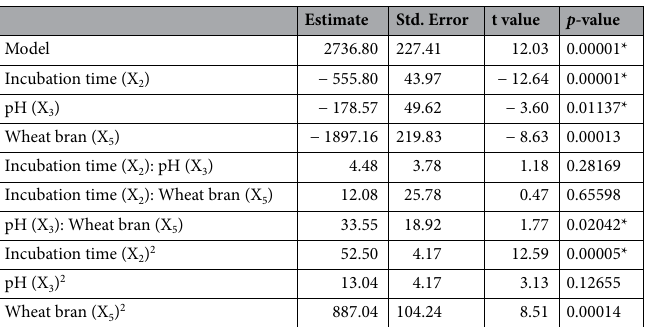
Table 7. Analysis of variance (ANOVA): and regression coefficients of the response surface quadratic model for the response variables for xylanase production by Trichoderma harzianum strain. *Significant p -value at p ≤ 0.05. Adjusted R 2 = 0.9117. Lack of fit p -value =